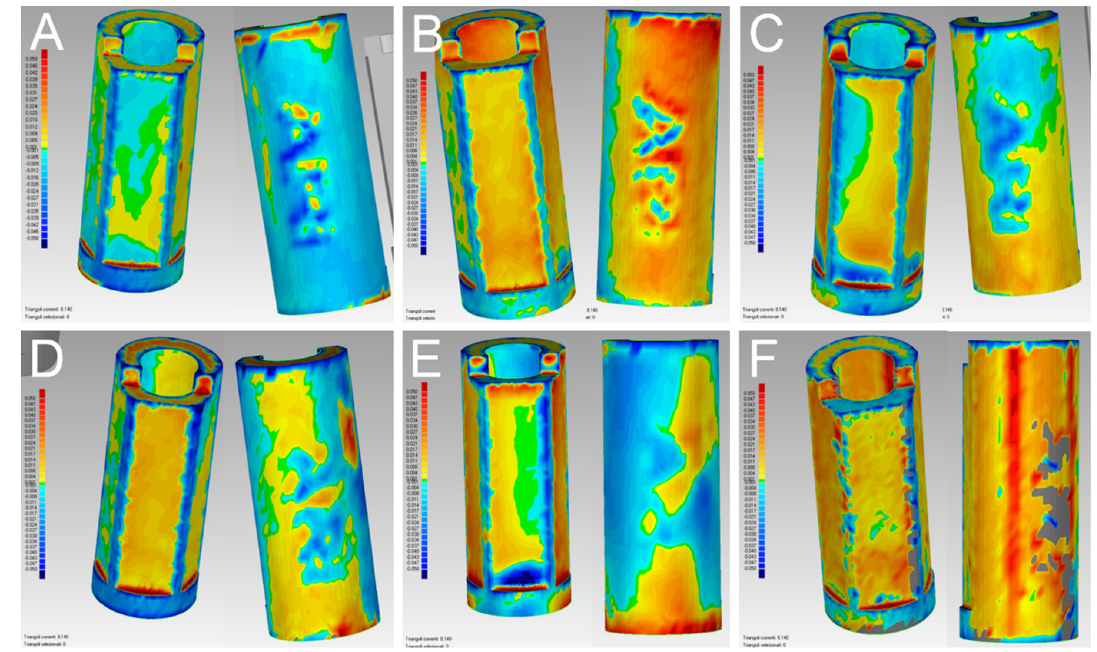
Figure 6. Quantitative evaluation with colorimetric map (frontal and back surface): best results obtained in the study. ( A ) With PRIMESCAN ® , the best single result amounted to 17 ± 19 μ m. ( B ) With CS 3700 ® , the best single result amounted to 20 ± 18 μ m. ( C ) With MEDIT i-500 ® the best single result amounted to 23 ± 26 μ m. ( D ) With ITERO ELEMENTS 5D ® , the best single result amounted to 27 ± 27 μ m. ( E ) With Emerald S ® , the best single result amounted to 26 ± 28 μ m. ( F ) With DOF UHD ® , the best single result amounted to 21 ± 21 μ m.